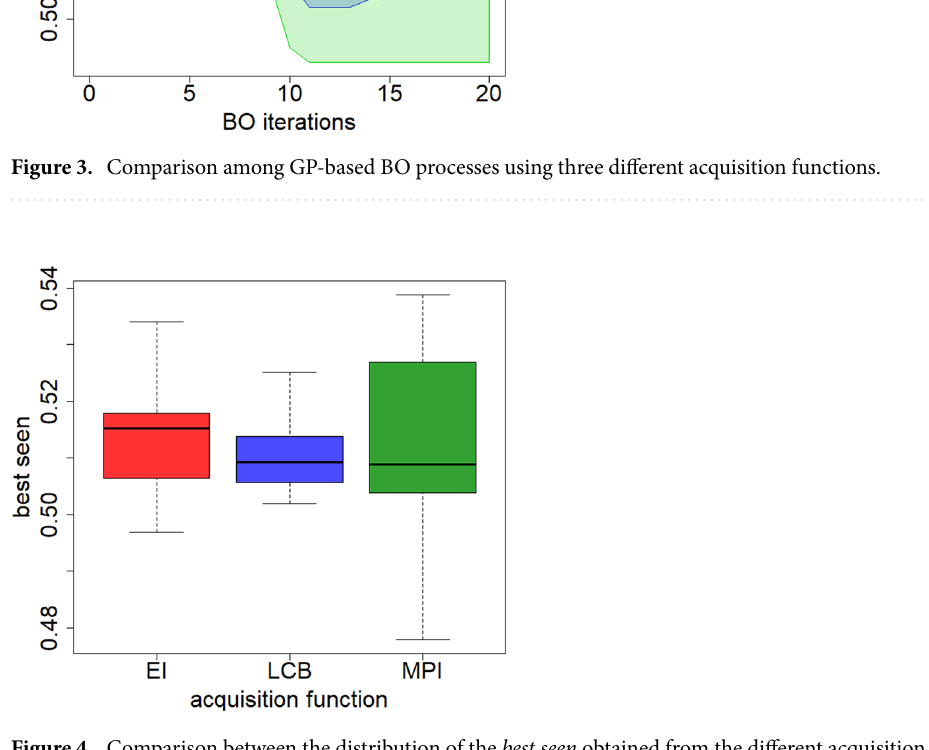
Figure 4. Comparison between the distribution of the best seen obtained from the different acquisition